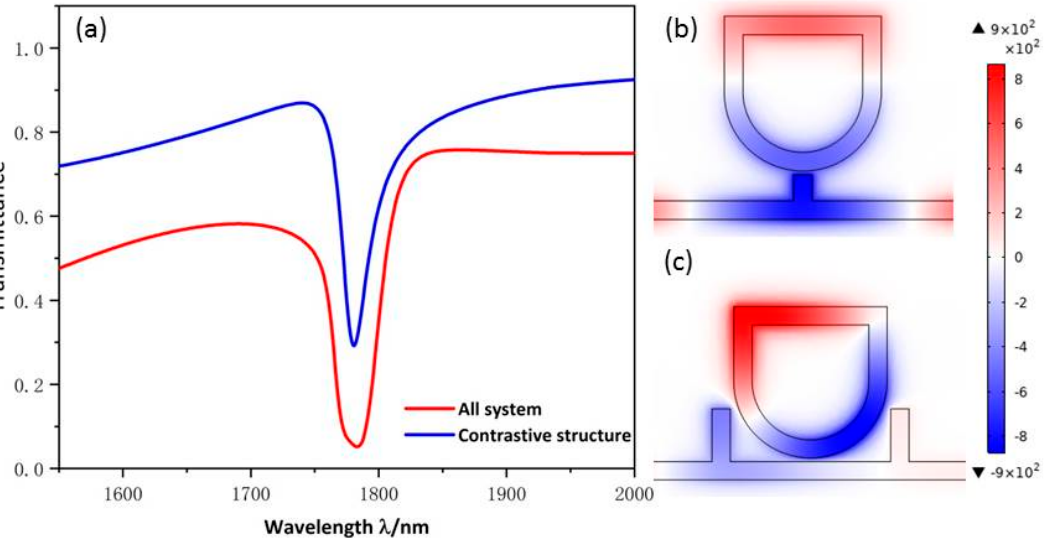
Figure 5. ( a ) Transmission spectra of two structures; ( b ) H z field distributions of the contrastive structure; ( c ) H (cid:2936) field distributions of the system.